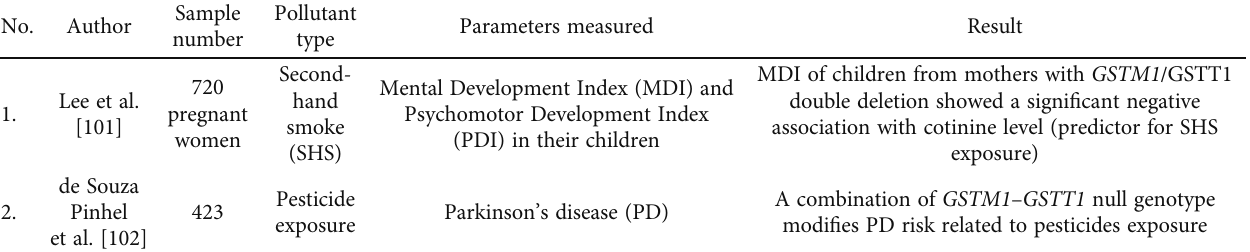
Table 5: Studies about GSTM1 null genotype e ff ect on air pollutant-induced nervous system disturbances.